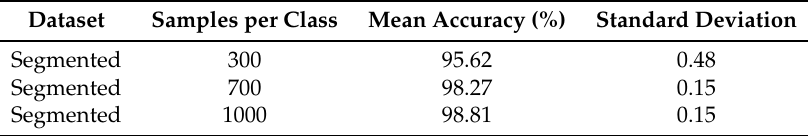
Table 5. Deep Learning experiments with the segmented